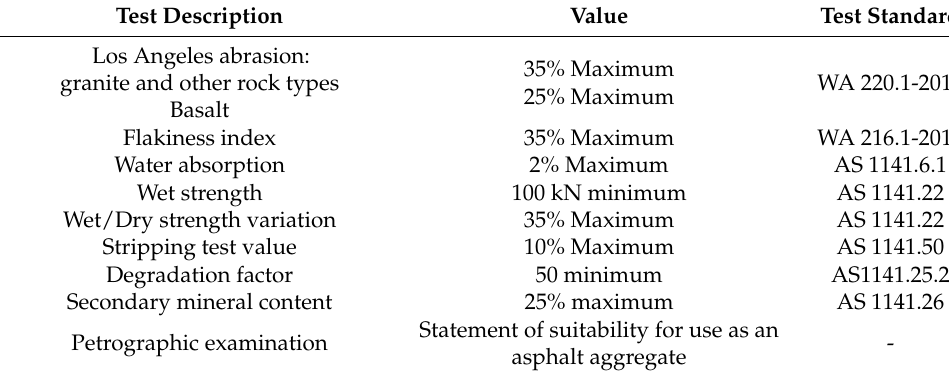
Figure 1. The particle-size distribution. Table 1. Aggregate properties.